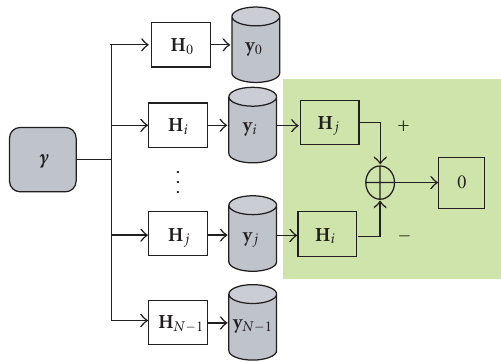
Figure 3: Cross-relations: the signal blocking transformation shown here is applied to all the channel pairs to span the null space of the channel